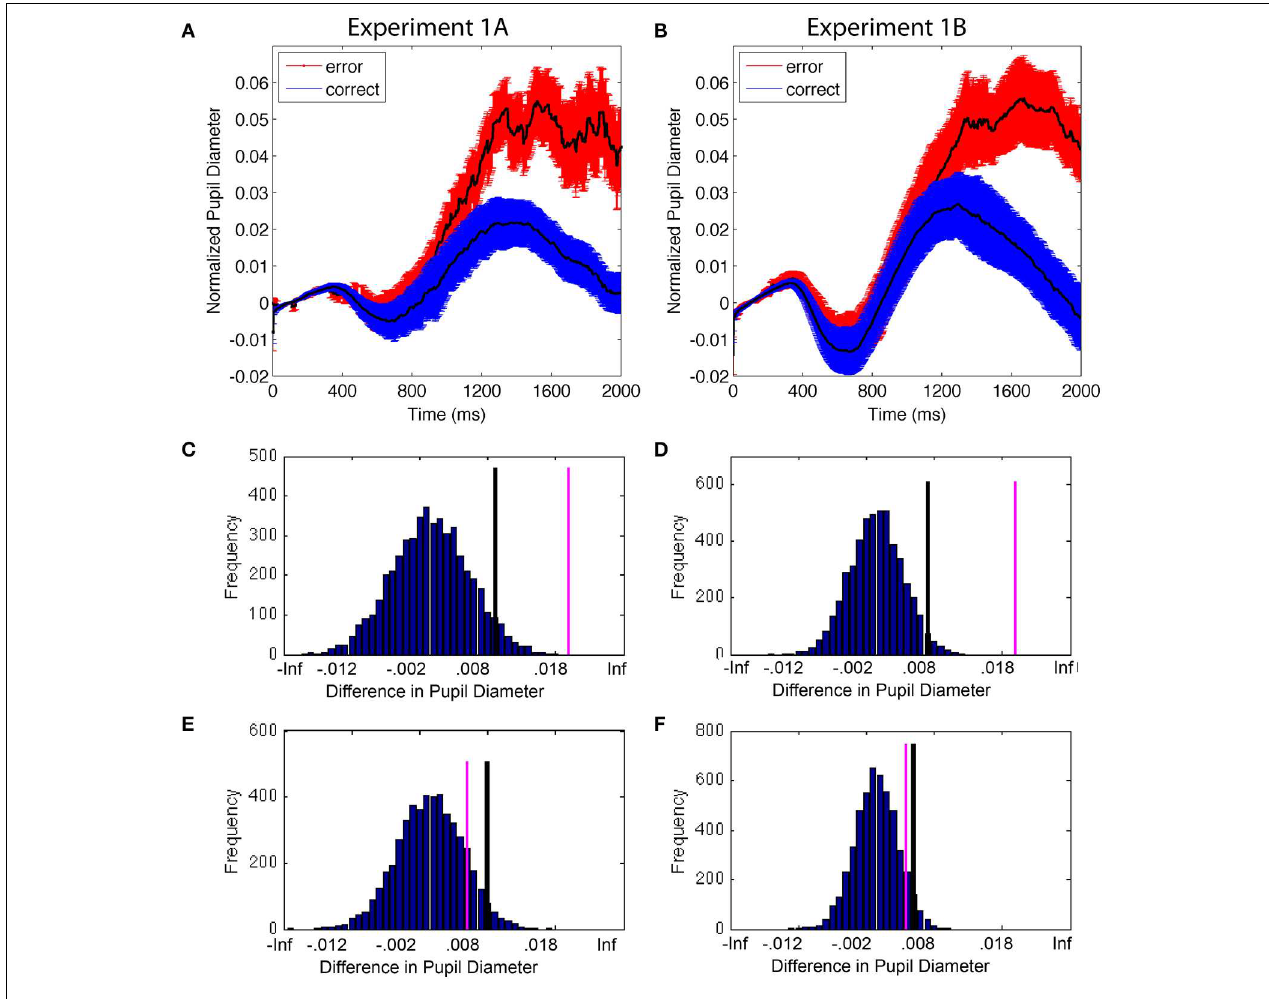
FIGURE 4 | (A,B) Mean change in pupil diameter on correct and error trials. Error bars are standard error of the mean. (C,D) Permutation results on the difference between pupil diameter as a function of accuracy during the cognitive period; the difference had a < 1% probability of occurring due to